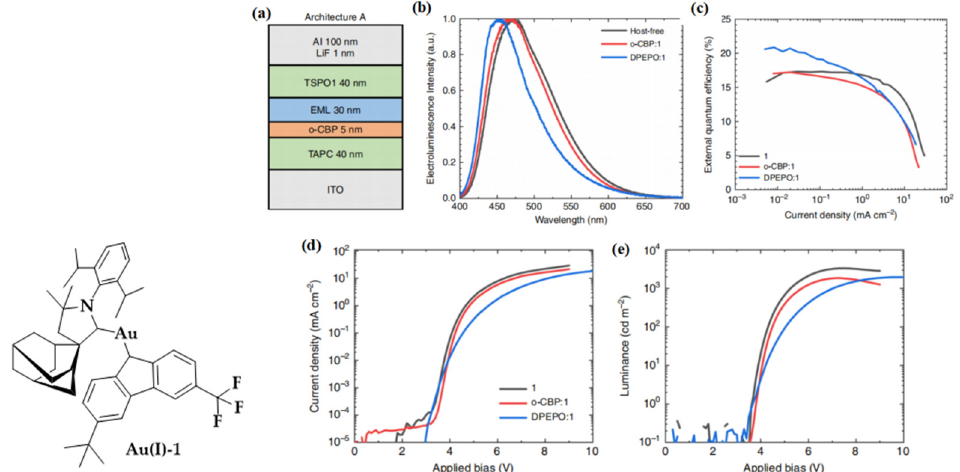
Figure 8. Molecular structure of Au(I)-1. ( a ) Schematic OLED architecture used; ( b ) normalized EL spectra, ( c ) EQE–current density, ( d ) current–voltage, and ( e ) luminance–voltage characteristics of OLEDs with Au(I)-1 in host-free and host-guest structures. Reproduced with permission from Patrick J. Conaghan et al., “Highly efficient blue organic light-emitting diodes based on carbene-metal-amides”; published by Springer Nature , 2020 [71].